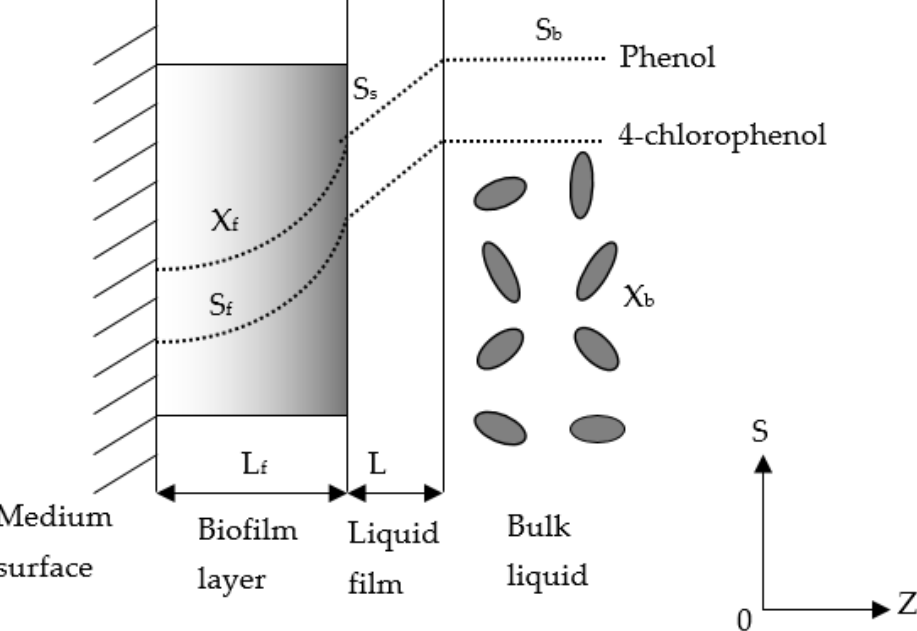
Figure 1. Concentration profiles of cometabolic substrates in the biofilm.